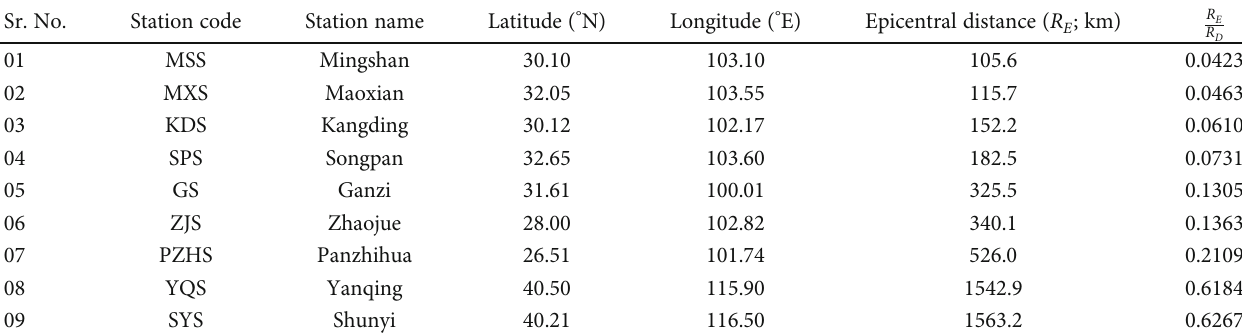
Table 1: List of Rn monitoring stations used in the current study along with their location and distance from the event epicentre. Sr. No.